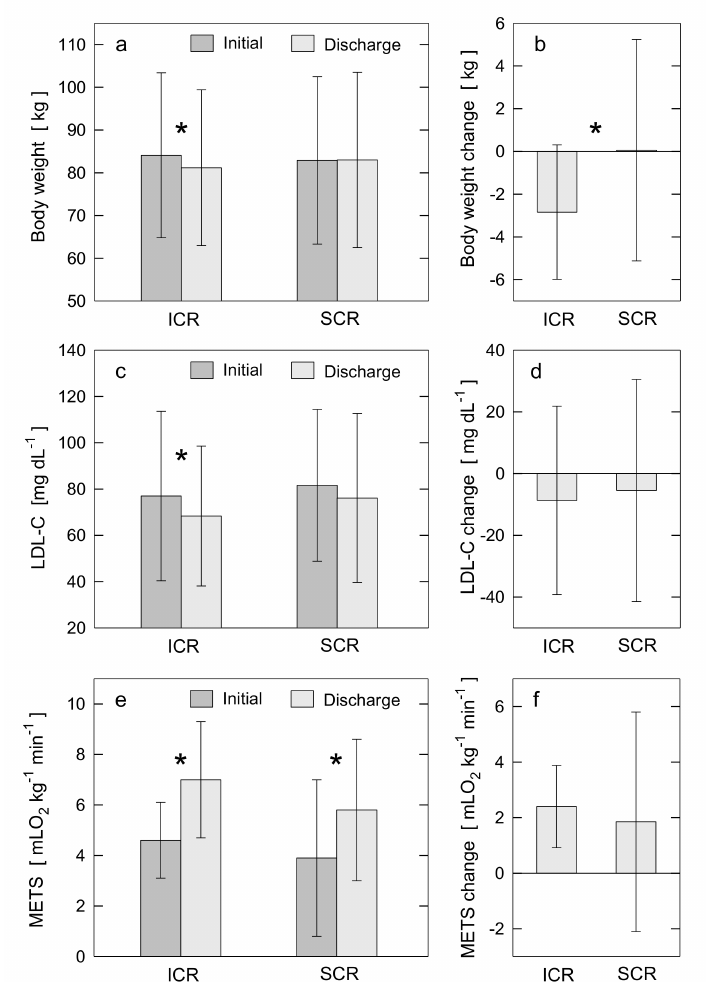
Figure 1. Changes in cardiometabolic outcomes between the entry (Initial) and discharge (Discharge) from the CR programs within ICR and SCR groups ( a , c , e ) and between ICR and SCR groups ( b , d , f ). ( a , c , e ) depict post-CR changes within ICR and within SCR groups in body weight, LDL-C, and peak EC quantified as METS, respectively. ( b , d , f ) depict the differences between ICR and SCR groups in post-CR changes for body weight, LDL-C, and METS, respectively. Each bar plot displays the mean value and standard deviation. The symbol * indicates the statistical significance for a given change in outcome. If symbol * is not placed, it indicates no statistical significance. For statistically significant results, the p -values are: panel a: p < 0.0001 for post-ICR change in body weight; c: p = 0.006 for post-ICR change in LDL-C; e: p < 0.0001 for post-ICR and post-SCR changes in METS; b: p < 0.0001 for difference in post-CR change in body weight between ICR and SCR. CR: cardiac rehabilitation; EC: exercise capacity; ICR: intensive cardiac rehabilitation; LDL-C: low-density lipoprotein cholesterol level; METS: metabolic equivalents; SCR: standard cardiac